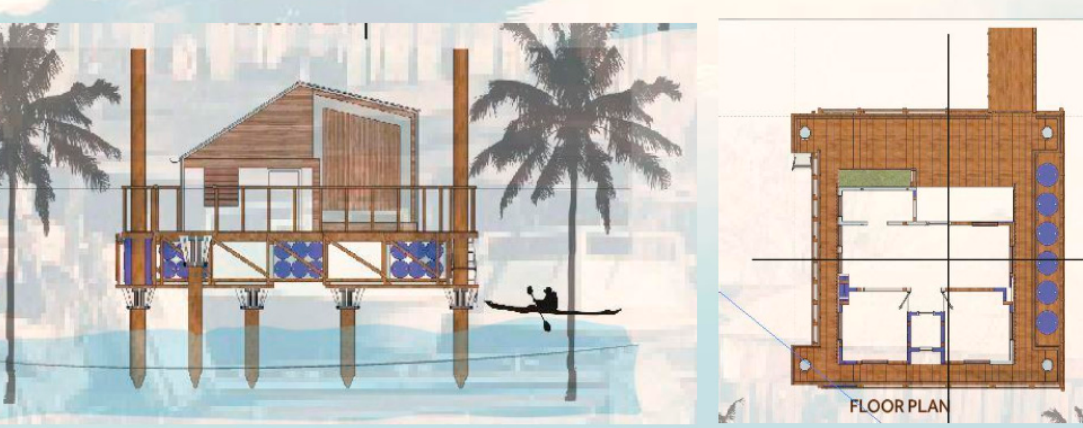
Figure 5. Group A’s proposal for a floating house in Igbokoda. Source: Climate Research for Development (CR4D) Charette Team, 2019.